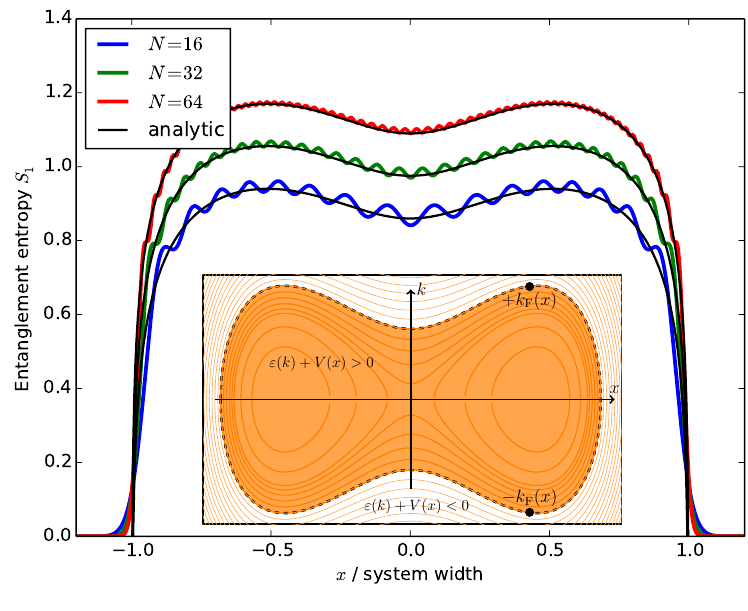
Figure 1: An example: a Fermi gas trapped in a double-well potential. To obtain non trivial results, we scaled the potential with the number N of particles so as to have a finite density inside each well. Our analytic prediction for the entanglement entropy is checked against numerical data for n = 1: the agreement is excellent, and improves further when increasing N . Inset: in phase space, the quasi-classical orbitals are equipotentials enclosing an area that is an integer multiple of 2 π